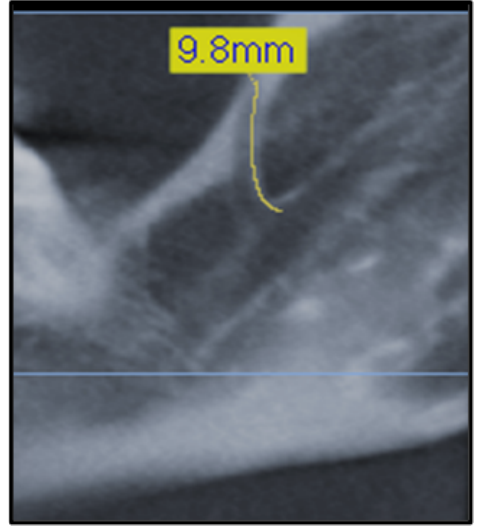
Figure 3. Measuring the length of a Type 1 canal. The upper and lower angles between the canals were also measured using CBCT with software processing of sagittal or panoramic sections (Figure